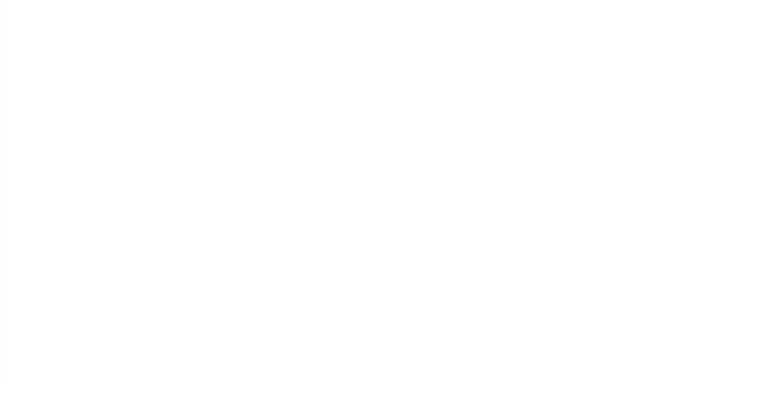
Figure 12. Smooth color gradient of RSSI values created from the template according to Figure